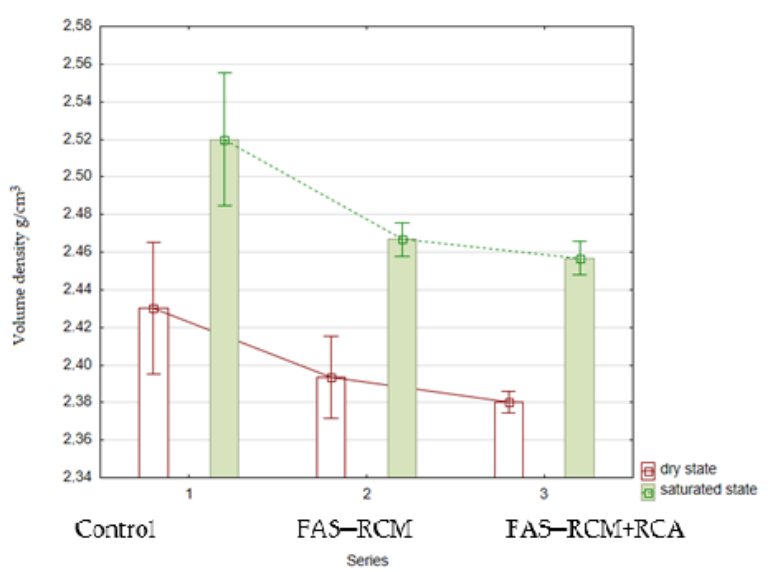
Figure 12. The average volume density of concrete in the saturated and dry state.